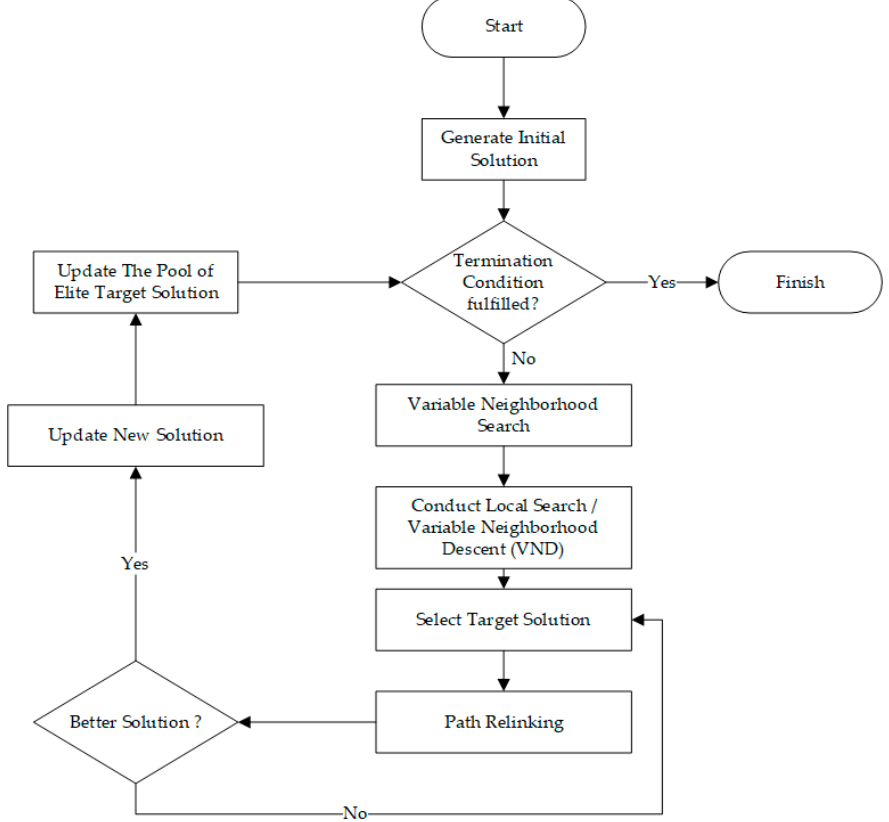
Figure 1. VNSPR framework.